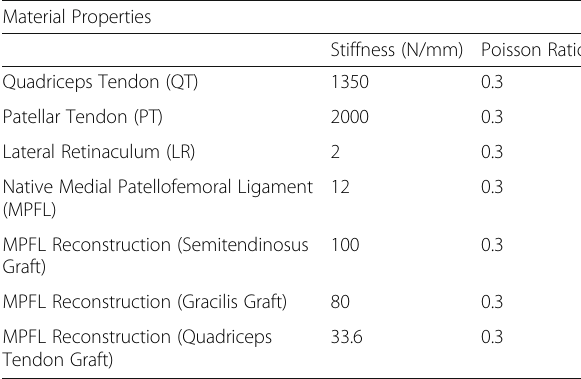
Table 2 Material properties considered for ligaments and tendons in the FEM